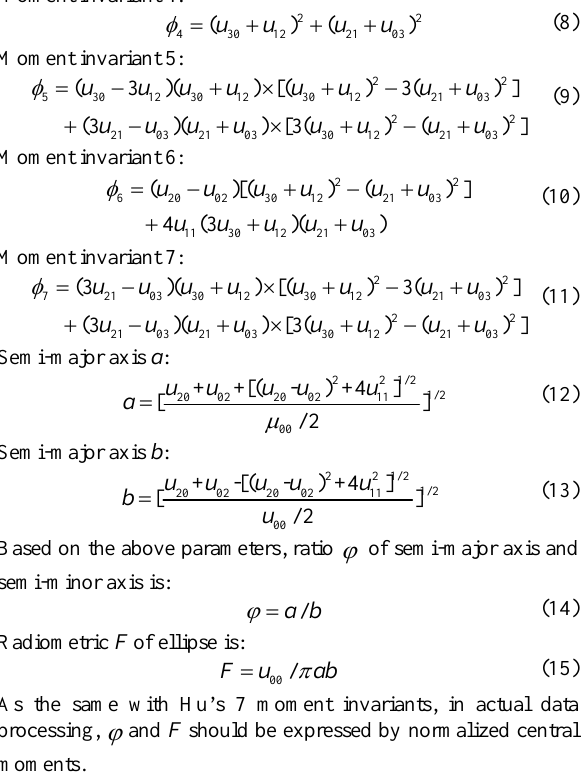
In this section, we experimented on the LiDAR point cloud data to confirm the recognition method for airplane targets proposed in this paper. The point cloud data to be identified is shown in Figure 2 (the red and green points respectively represent ground and non-ground points), which contains 23128 points and with a density of 2.4 points/m 2 , and the results of target recognition are shown in Figure 3 (the green and red points respectively represent airplane target and other target points).